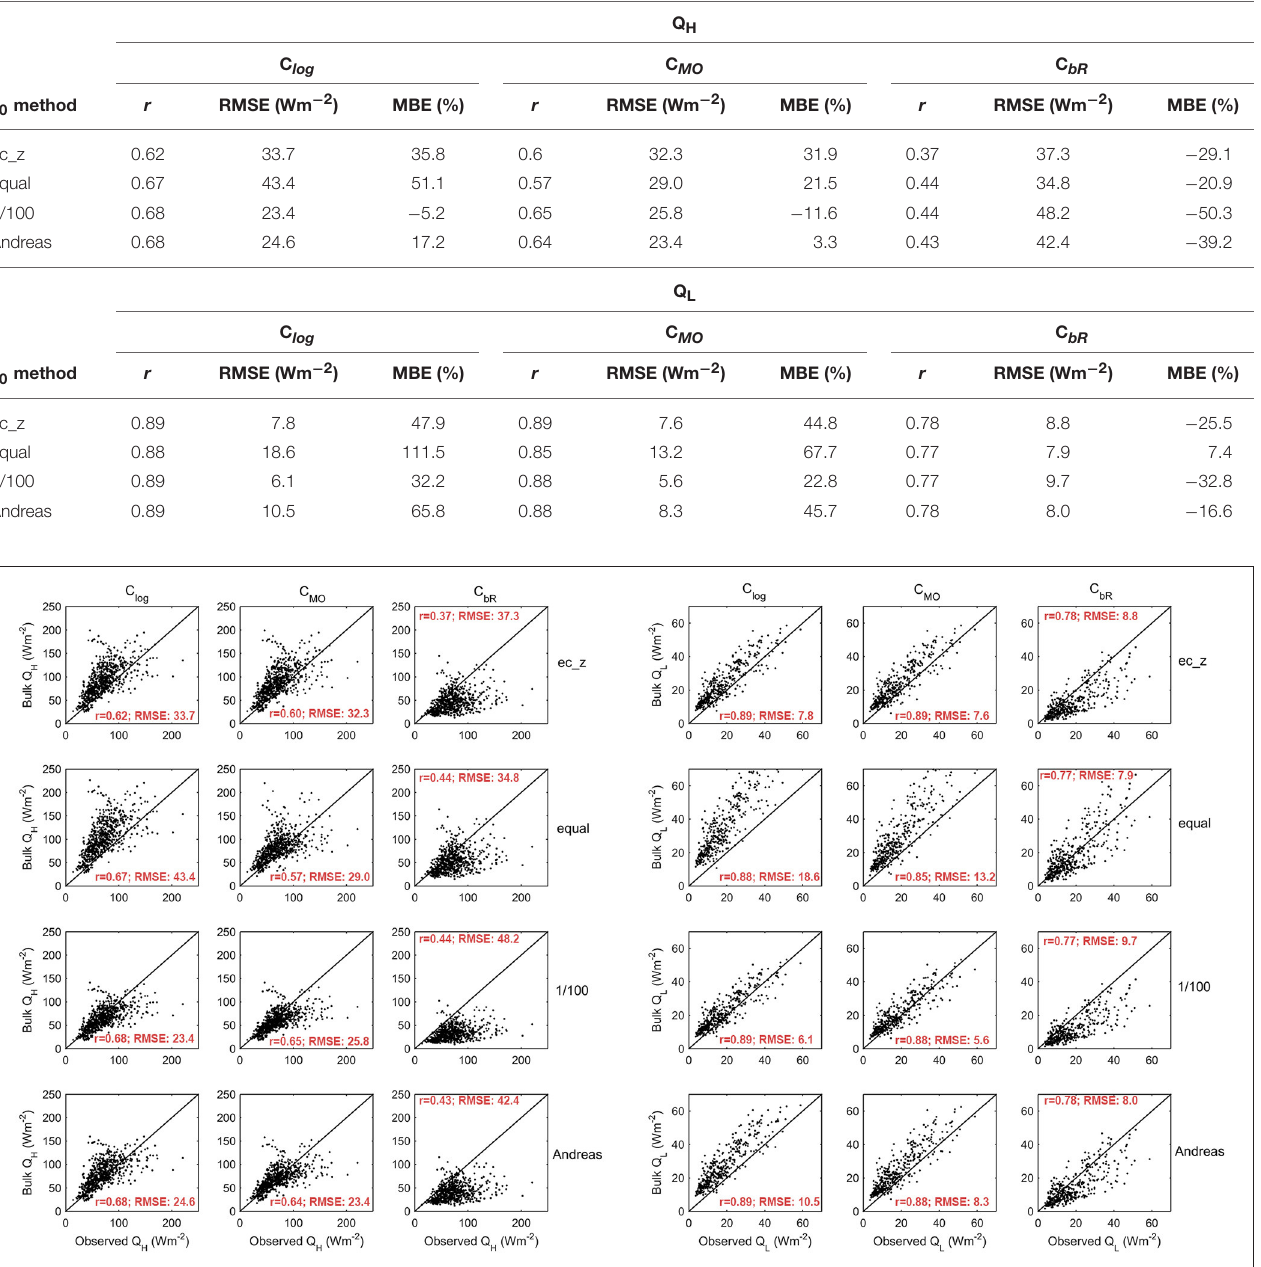
FIGURE 7 | Performance of the tested bulk methods in modeling the EC-observed turbulent fluxes of sensible and latent